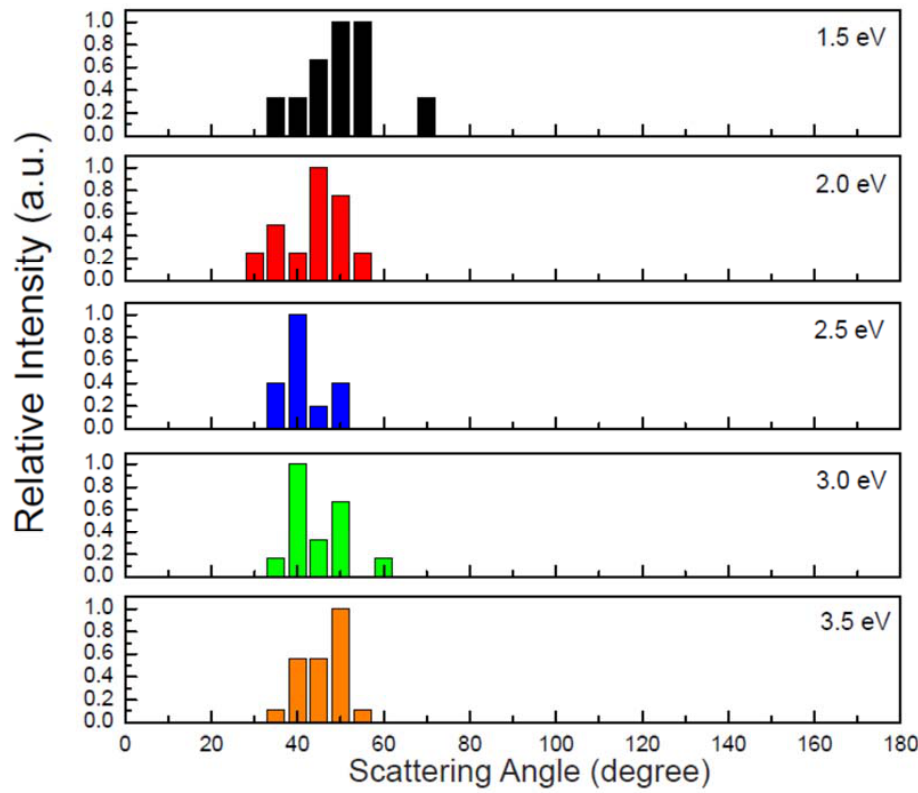
Figure 8. Angular distributions of the OH − product. The relative intensities are normalized with the respective maximum values.